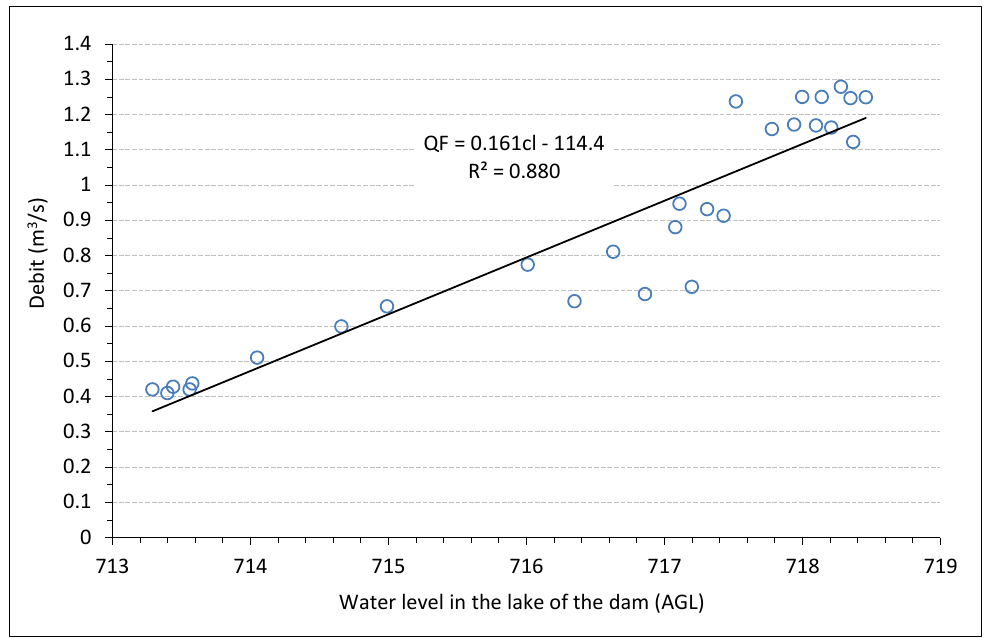
Figure 36. Variation of the leaked flow as a function of the water level for heights less than 718.5 m at Hammam-Grouz dam The values of the measured leakage rate over time for ratings between 713.5 and 718.5 m are in the range of 0.4 to 1.3 m 3 /s and vary linearly with the rise of the body of water explaining 88% of the variance. Figure 37 elucidates the change in leak flow as a function of the lake's elevation for ratings between 720.5 and the normal reservoir